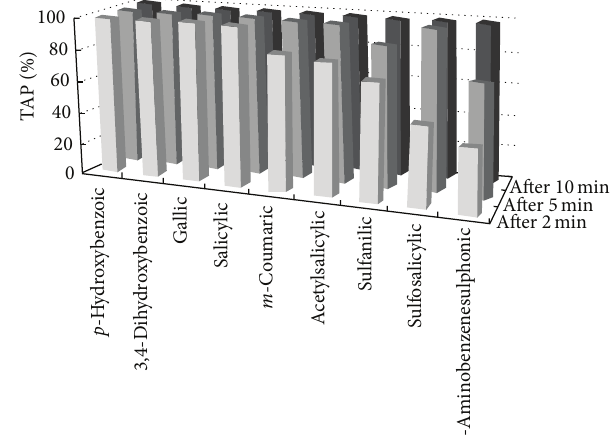
Figure 8: The degradation steps of different aromatic acids obtained after different times of their reactions with the hydroxyl radicals.